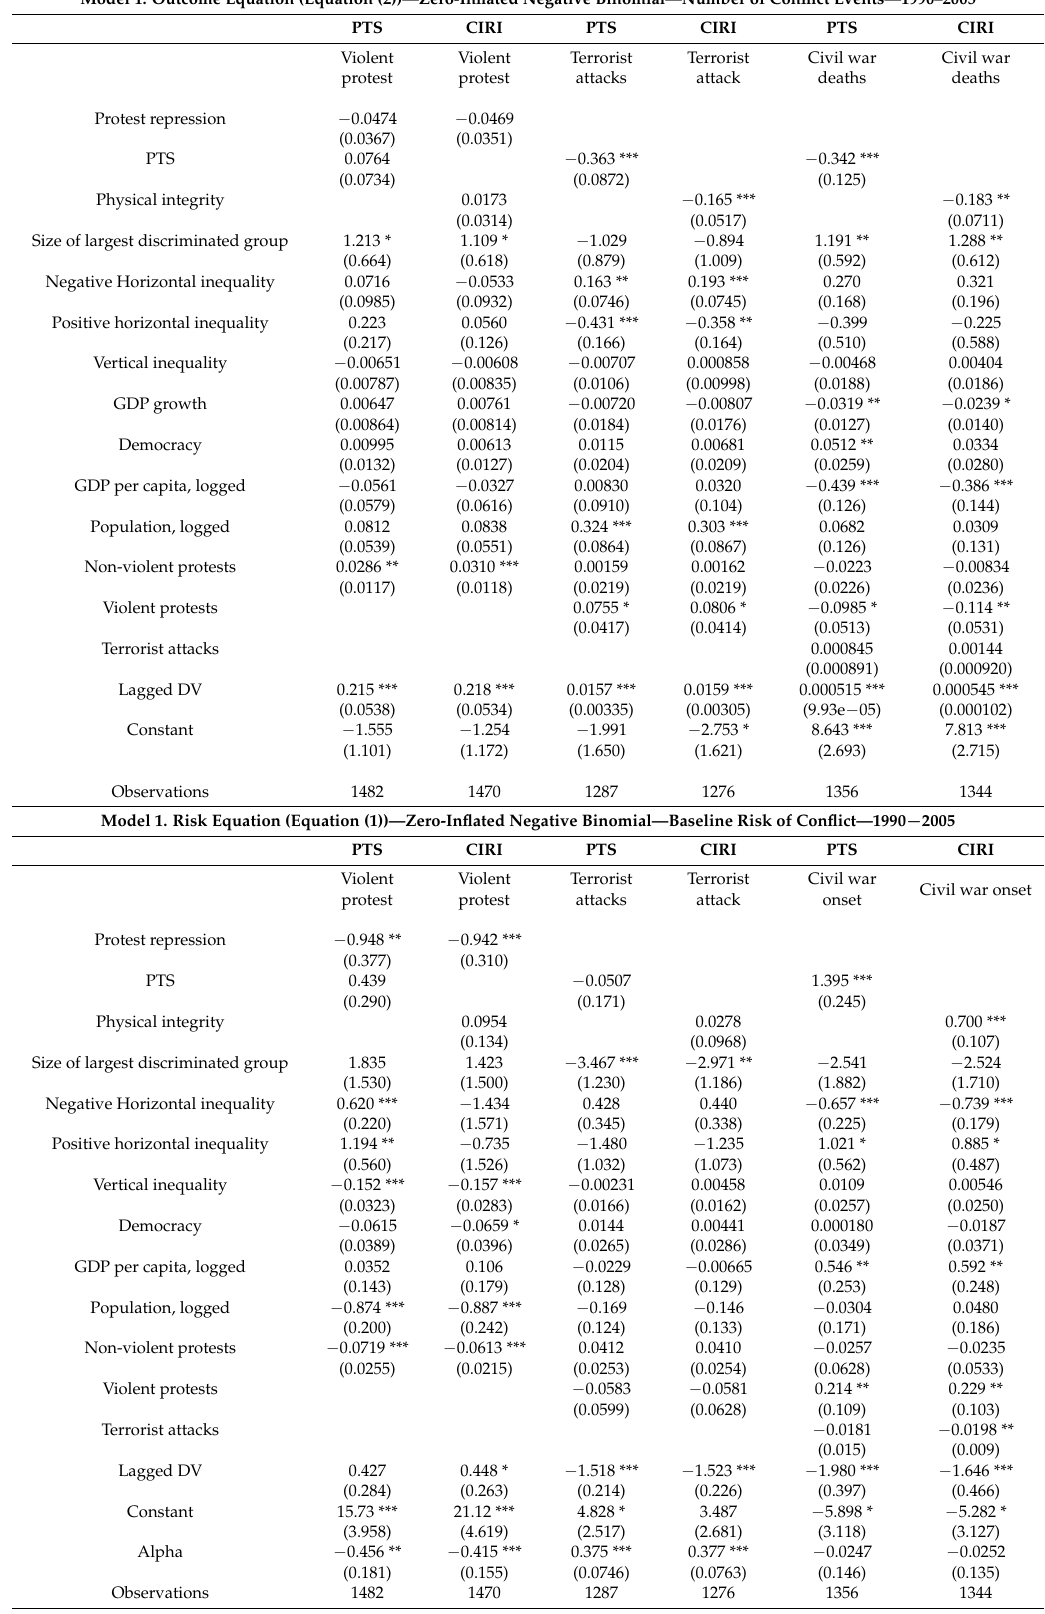
Table A3. Respect for physical integrity rights, inequality and internal conflict, full